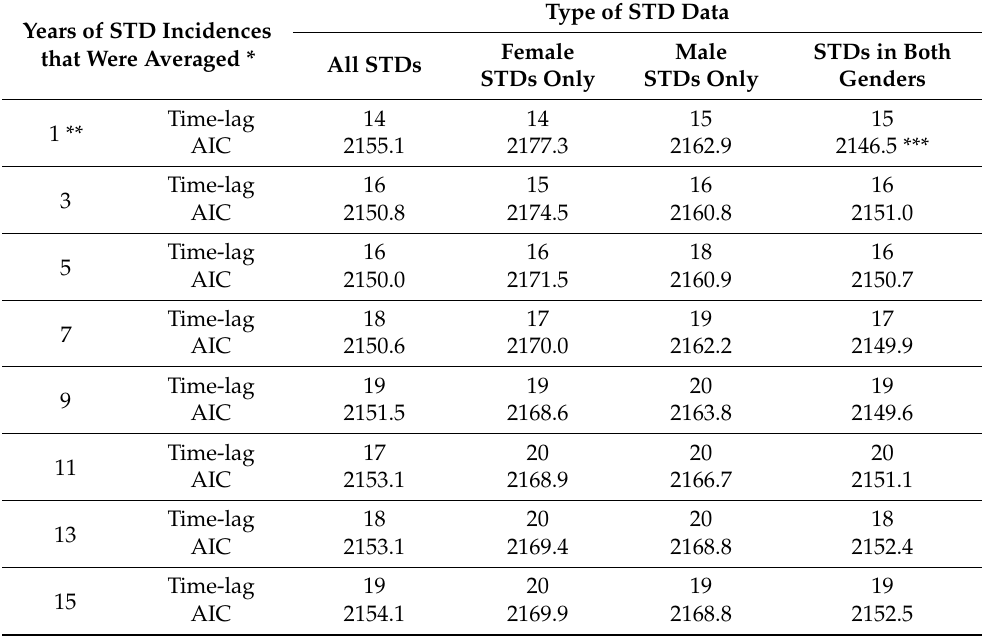
Table 2. The different settings in the use of STD data and the time-lag between the STD incidences and CC incidences with the Akaike information criterion